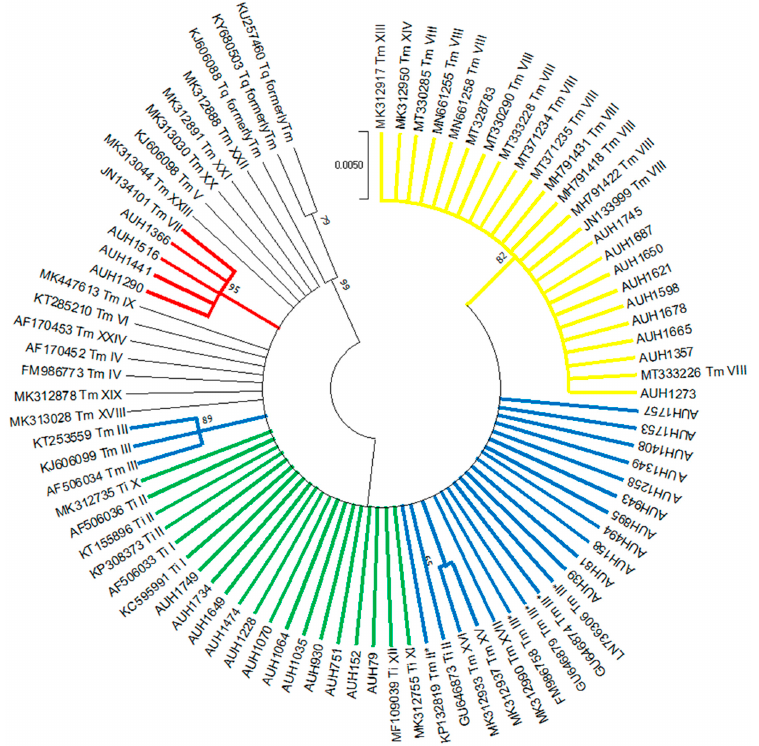
Figure 1. Maximum likelihood phylogenetic tree of T. interdigitale ( Ti ) and T. mentagrophytes ( Tm ) genotypes based on ITS sequencing. Values at the nodes indicate bootstrap percentages based on 1000 replicates and only branches with bootstrap values above 50% are shown (different clades are highlighted using different colors). ITS sequences of several reference isolates and clinical strains retrieved from the GenBank [21,22] were used for comparative analysis. The isolates of the present study are marked with the prefix AUH.